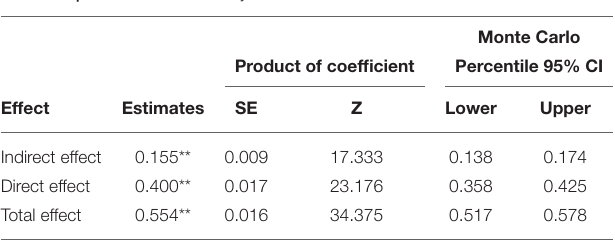
TABLE 6 | Mediation effect analysis.